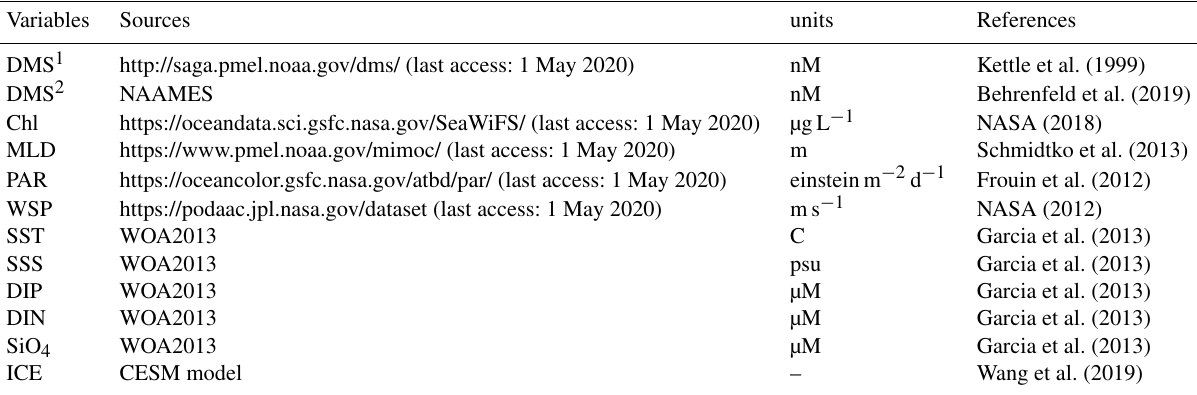
Table A1. DMS and ancillary data sources.